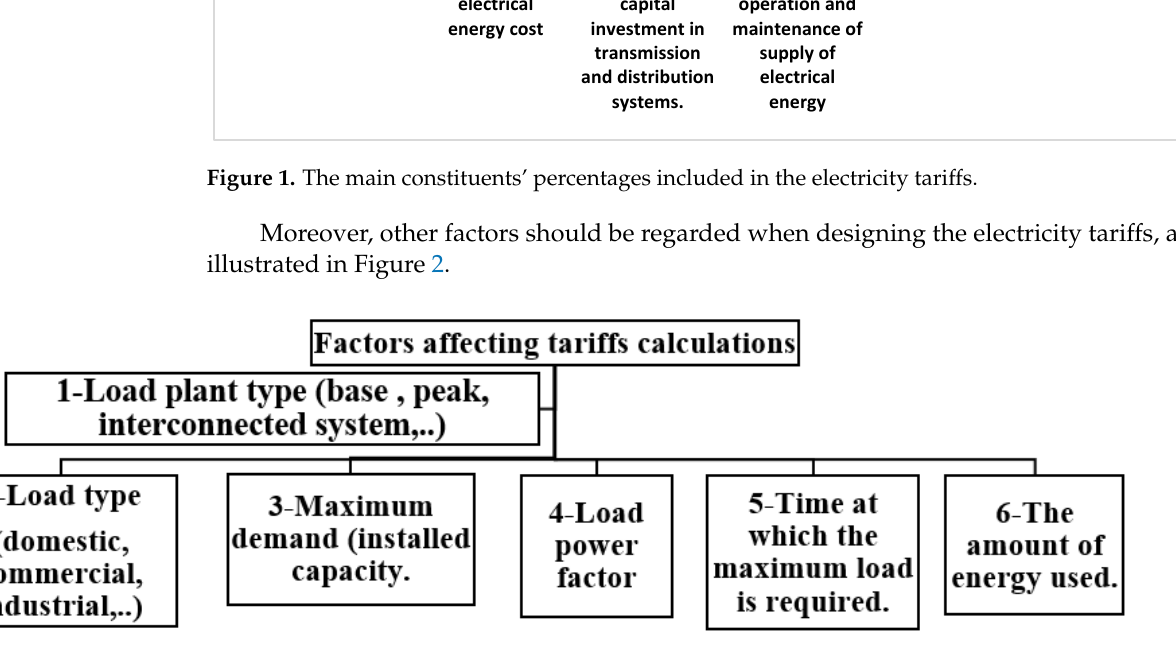
Figure 2. Factors affecting electrical tariff calculations.